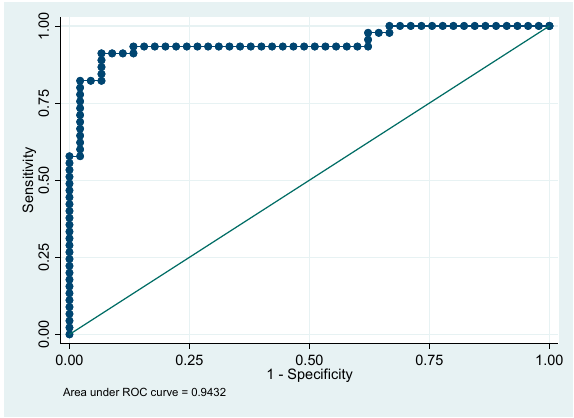
Figure 1. The ROC curve of the model three years before failure.